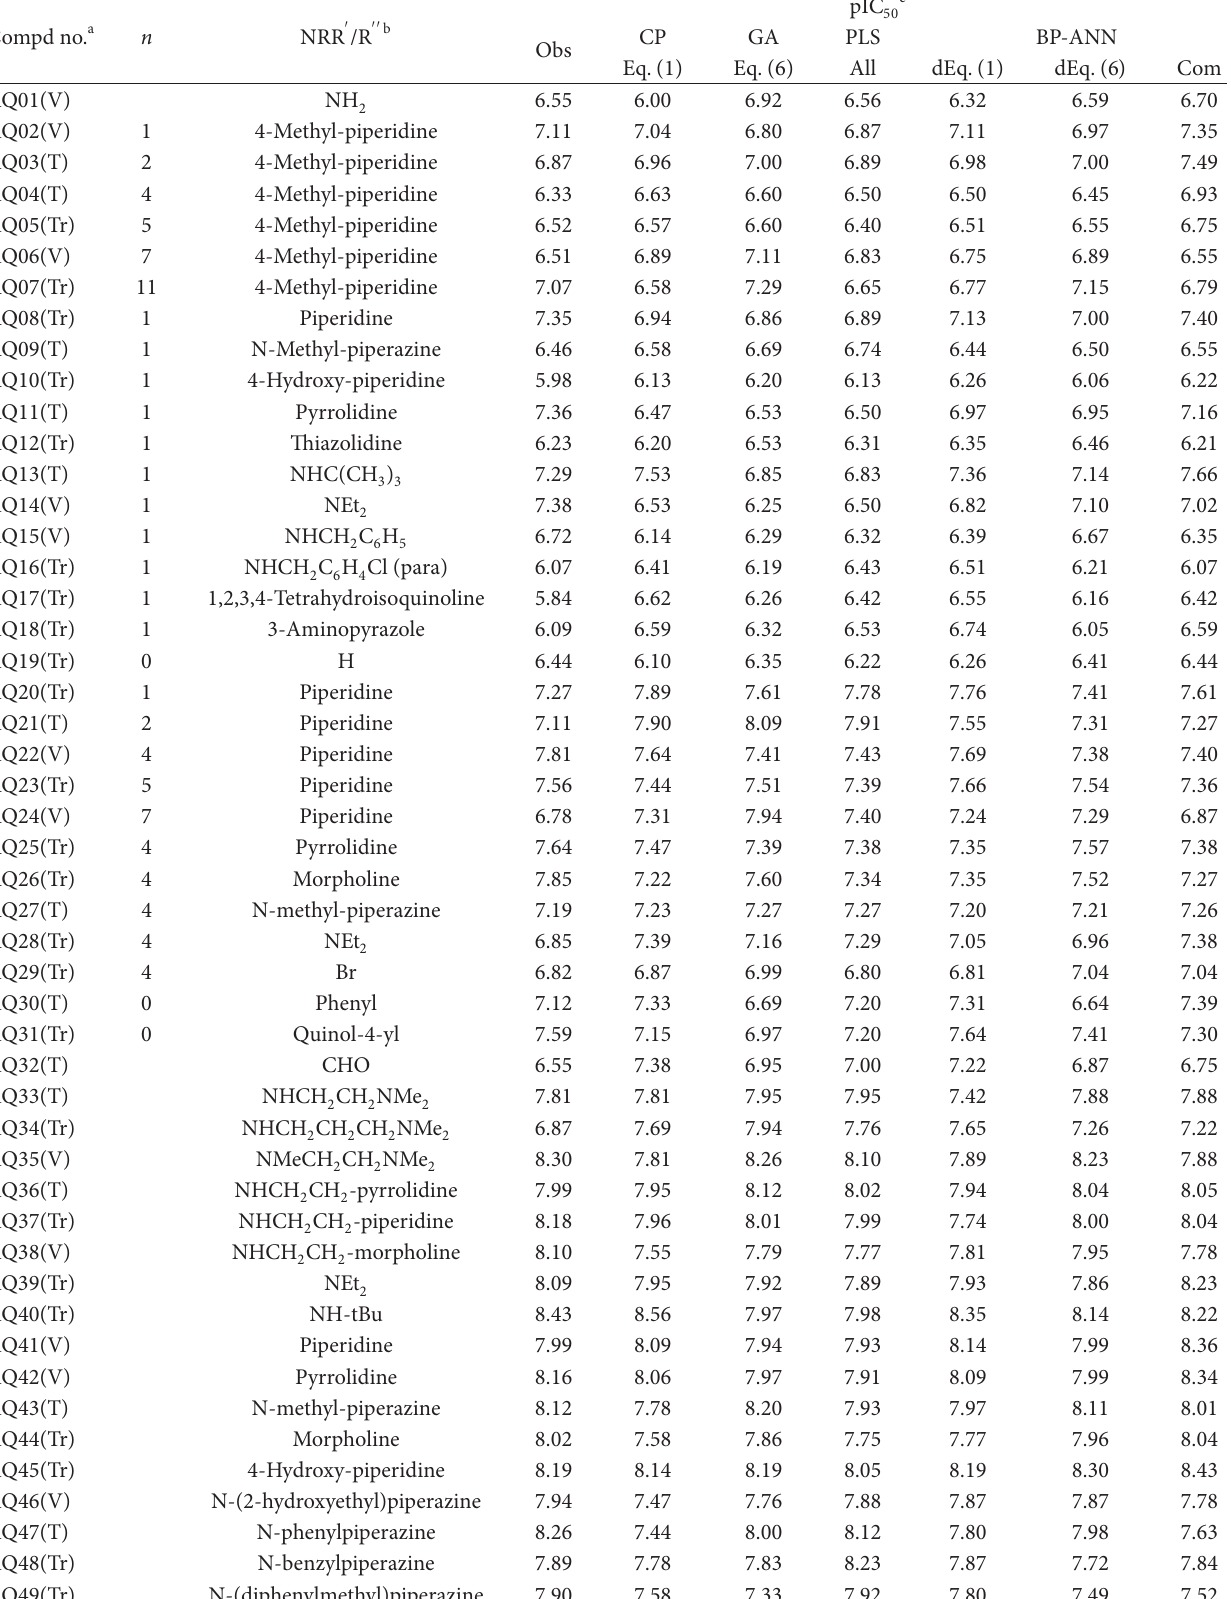
T 2: Anilinoquinolines (Figure 1(b); Table 1) and their observed and predicted antimalarial